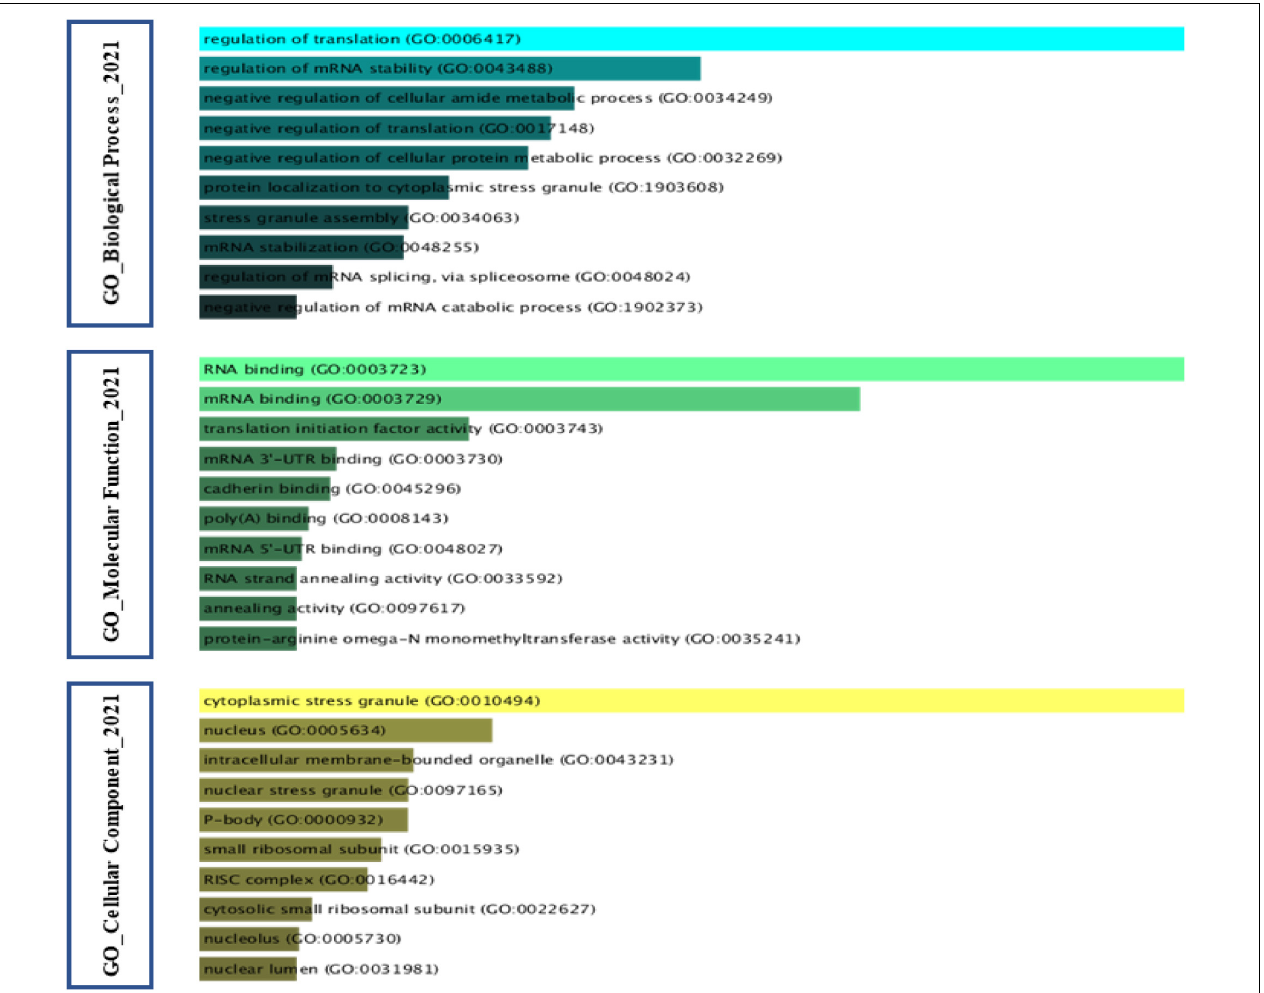
FIGURE 7 | Gene Ontology analysis of Stress Granules protein components in cancer. Gene Ontology analysis was performed on SGs protein components in cancer based on the Table 1 . The GO cellular component found that most of the proteins embedded in the structure of SGs exhibit their function in both the cytoplasm and the nucleus. According to GO biological process, the impact on the stability of transcript of factors involved in cancer cell proliferation is one of the networks in which SGs can intervene. GO molecular function analysis further considers a feature such as RNA binding to the protein component of SGs.